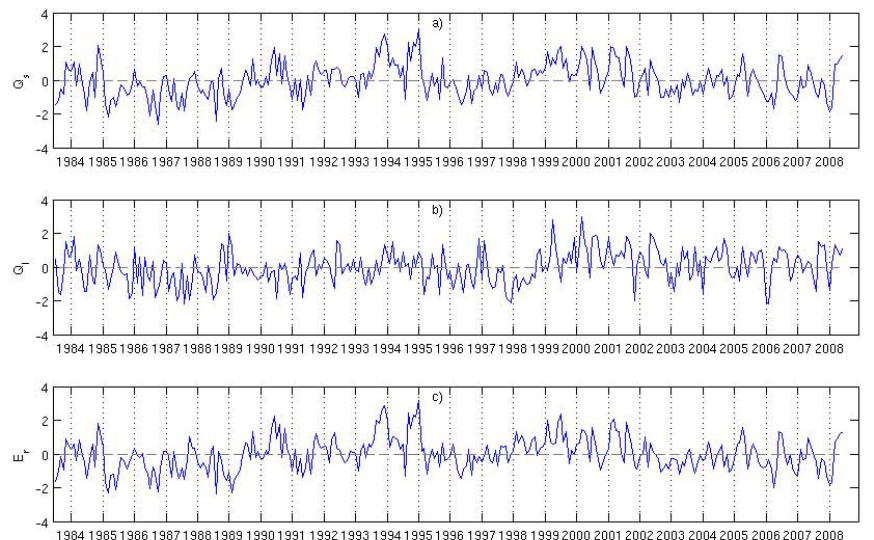
Fig. 5. Normalised anomalies of (a) net solar flux Q s , (b) net terrestrial flux Q l , and (c) energy balance evaporation E r , all calculated by our radiation transfer